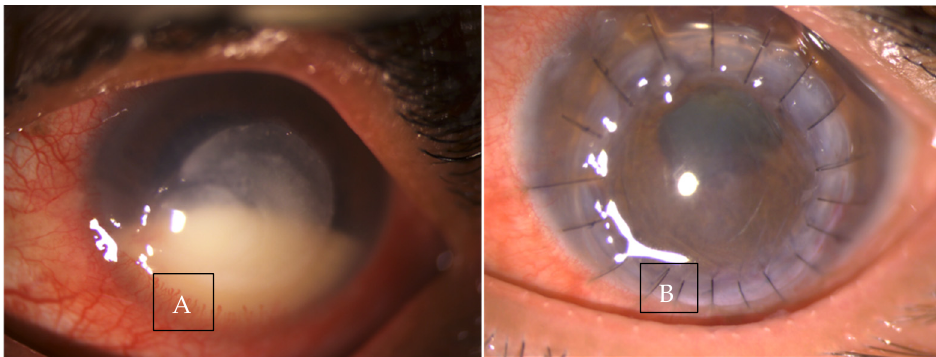
Figure 6. Clinical photograph ( A ) in a case of recalcitrant fungal keratitis with impending perforation ( B ) showing post operative day 1 picture post therapeutic keratoplasty.